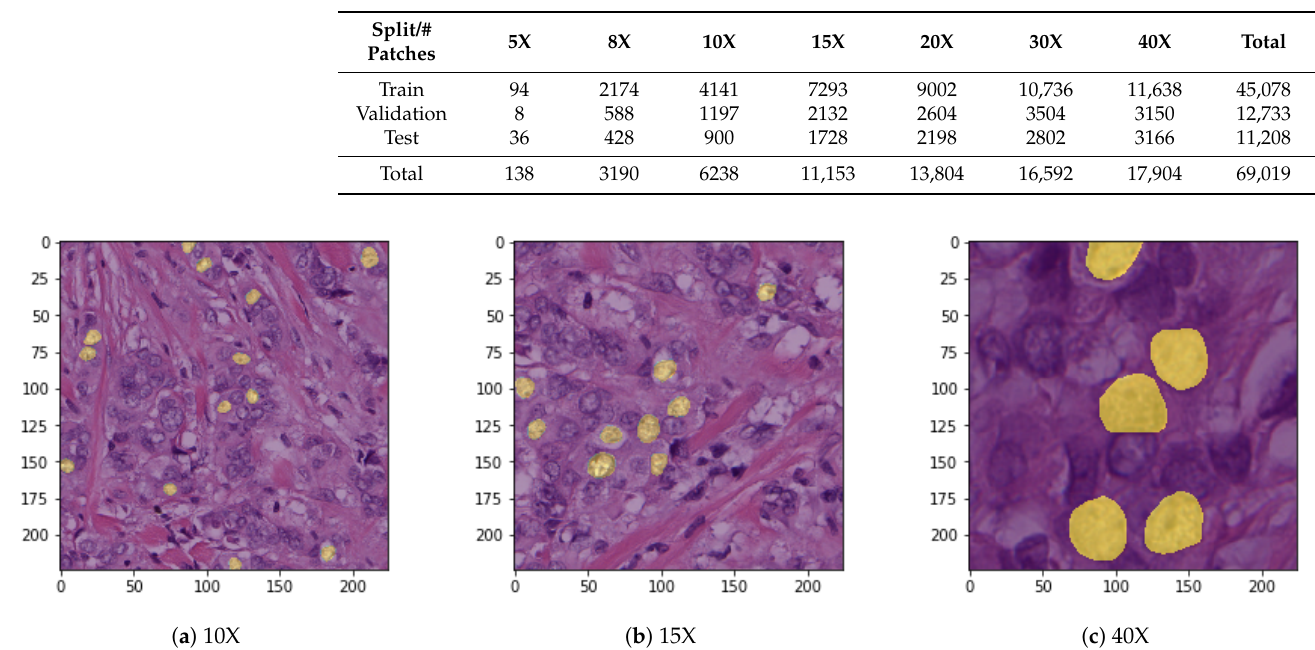
Figure 2. Examples of histopathology images at 10, 15 and 40X with nuclei